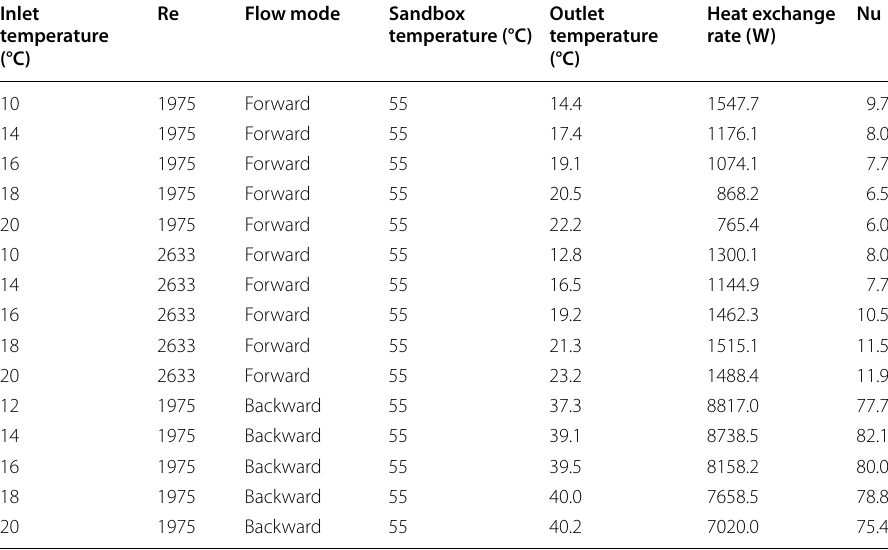
Table 1 Experimental results for different inlet temperatures Inlet